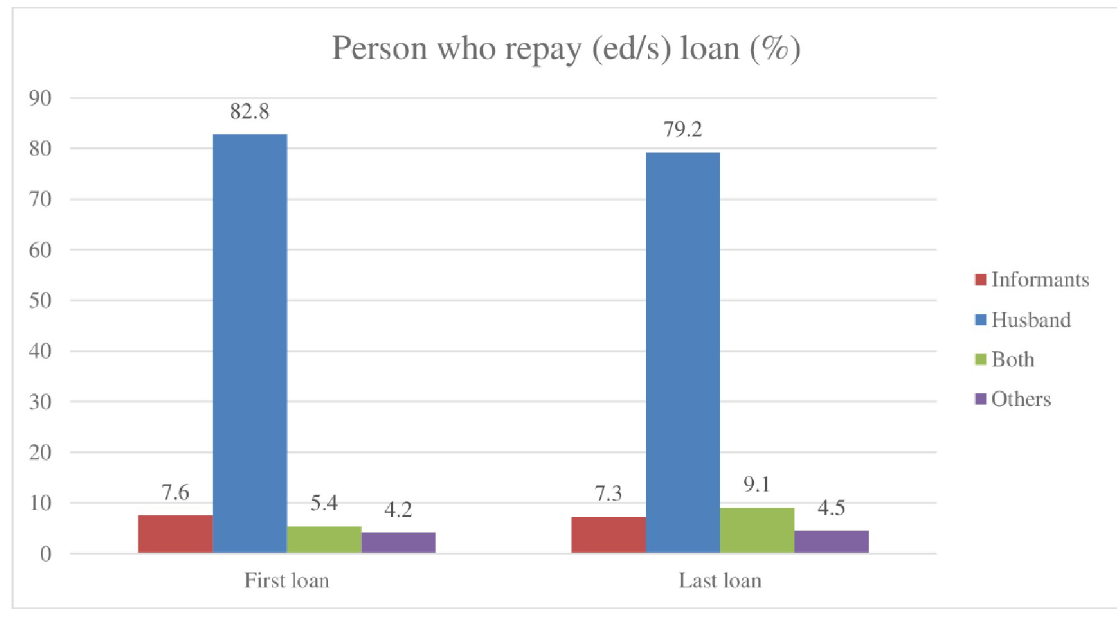
Fig 3. Loan repayments.